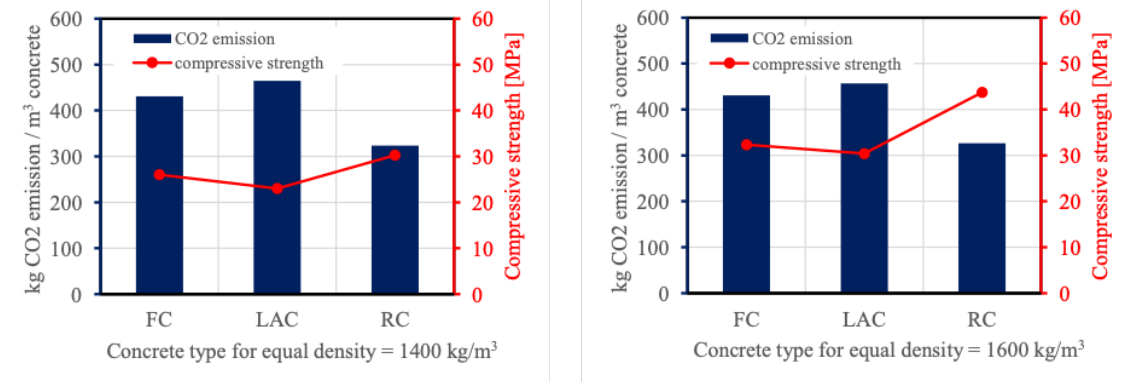
Figure 3. CO 2 emission comparison alongside related compressive strength values among three classes of concrete for equal density of 1400 kg/m 3 (left) and 1600 kg/m 3 (right).